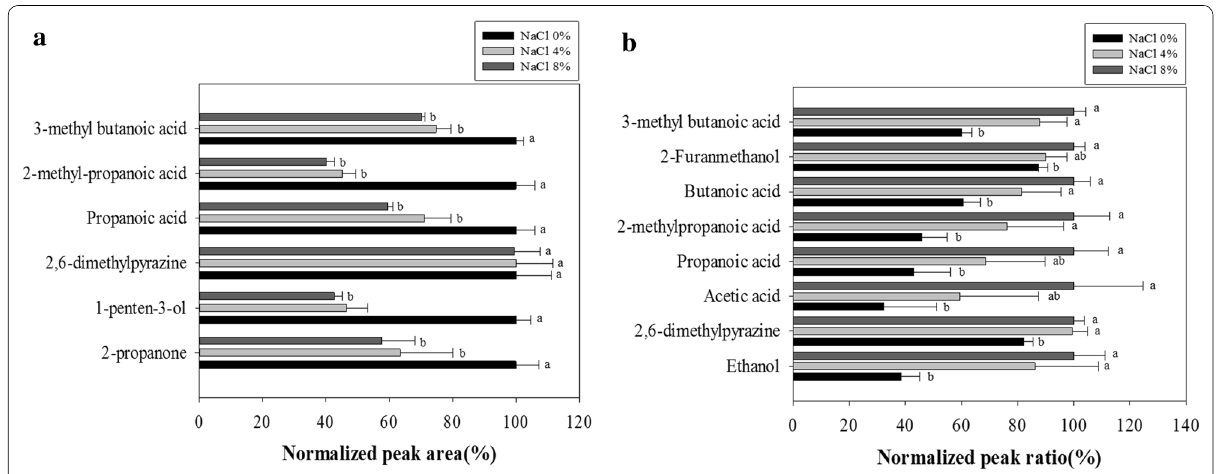
Fig. 4 Effect of salt addition using a SPME and b SPME‑Arrow methods for the extraction of volatile compounds in fish sauce ( p <